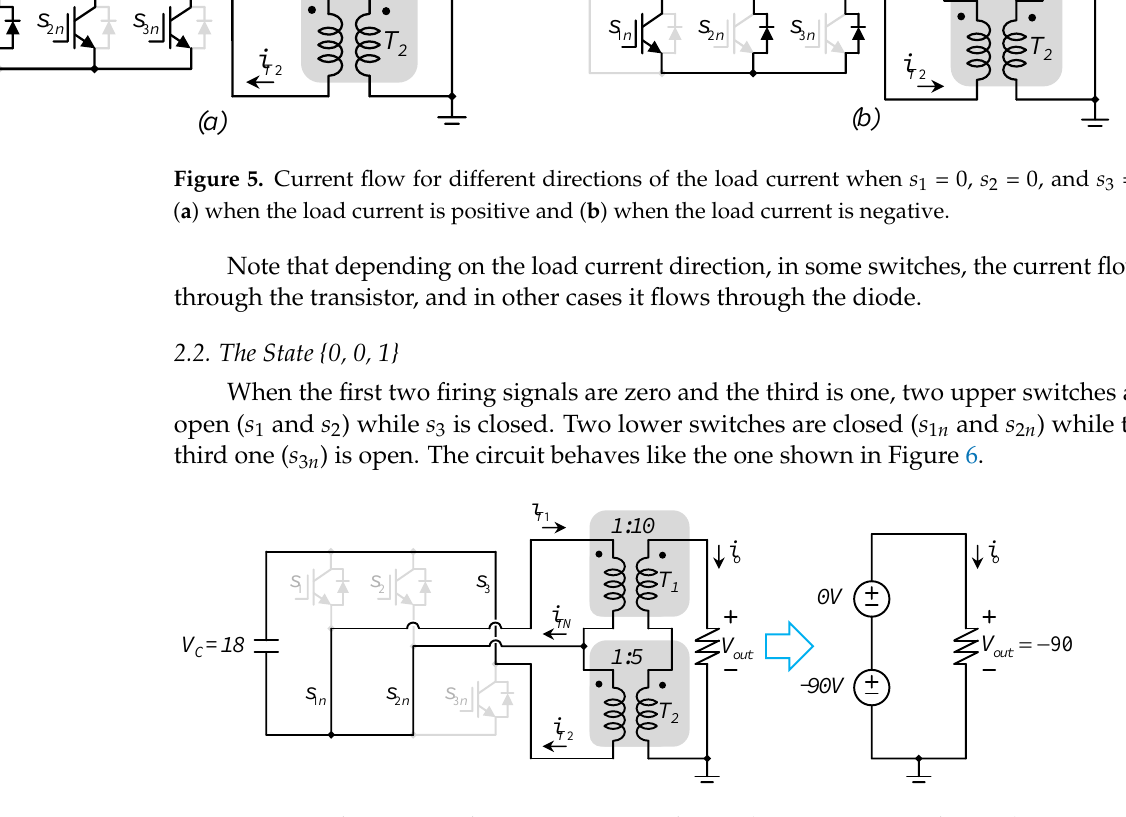
The primary winding of the transformer T 1 is shorted (connected to zero volts), while